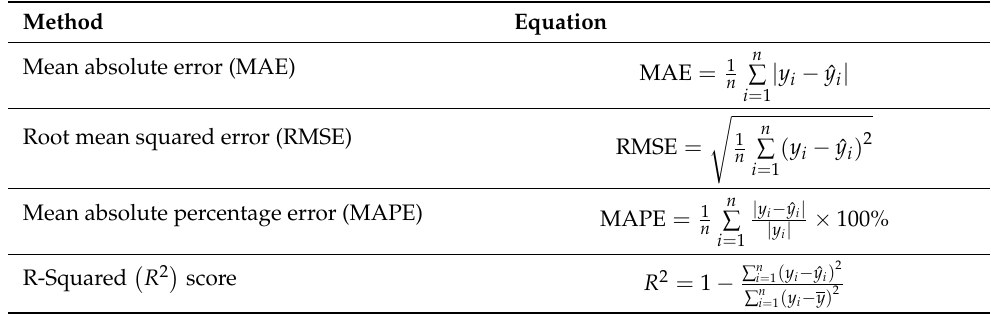
Table 8. Commonly used performance metrics.